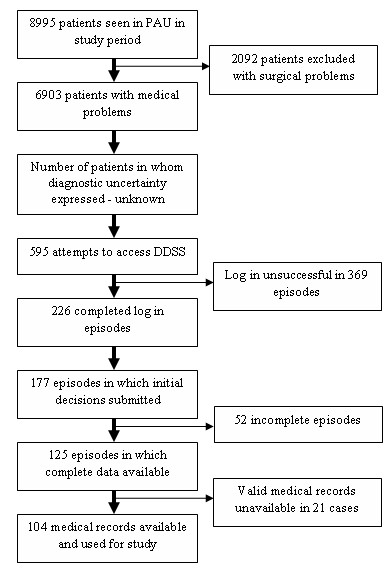
Flow diagram of patients and data through the study.